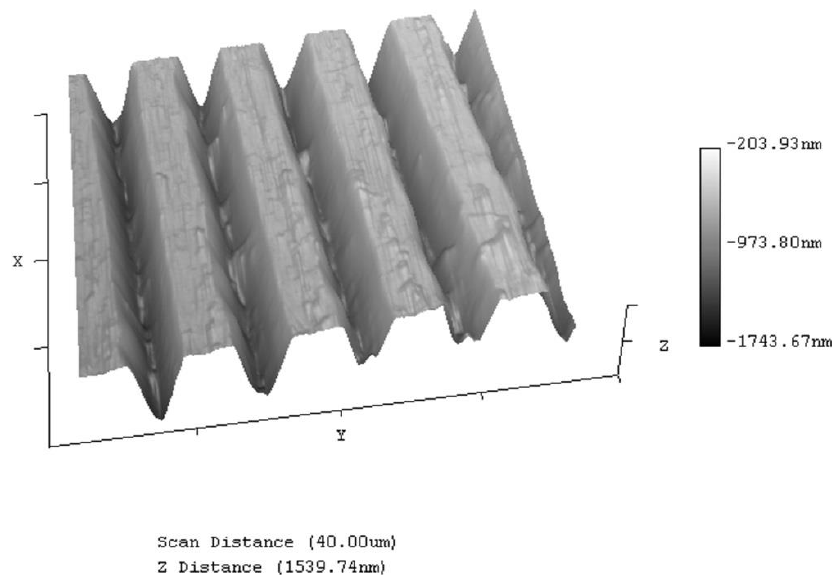
Table 2. Breakup periods of fractal-type nanostructures on the Z-plane of a LiNbO 3 :Gd (0.44 wt.%) crystal.